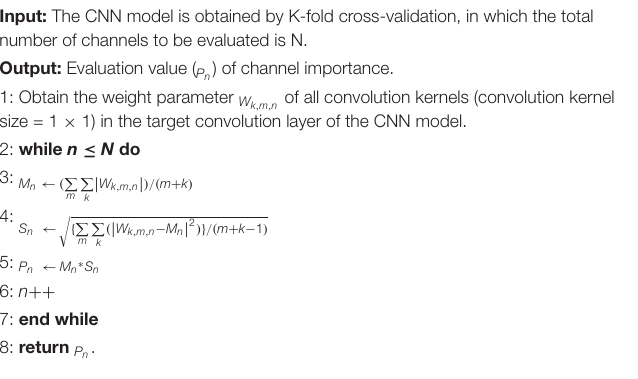
Algorithm 1: Evaluation of channel importance algorithm by convolution kernel